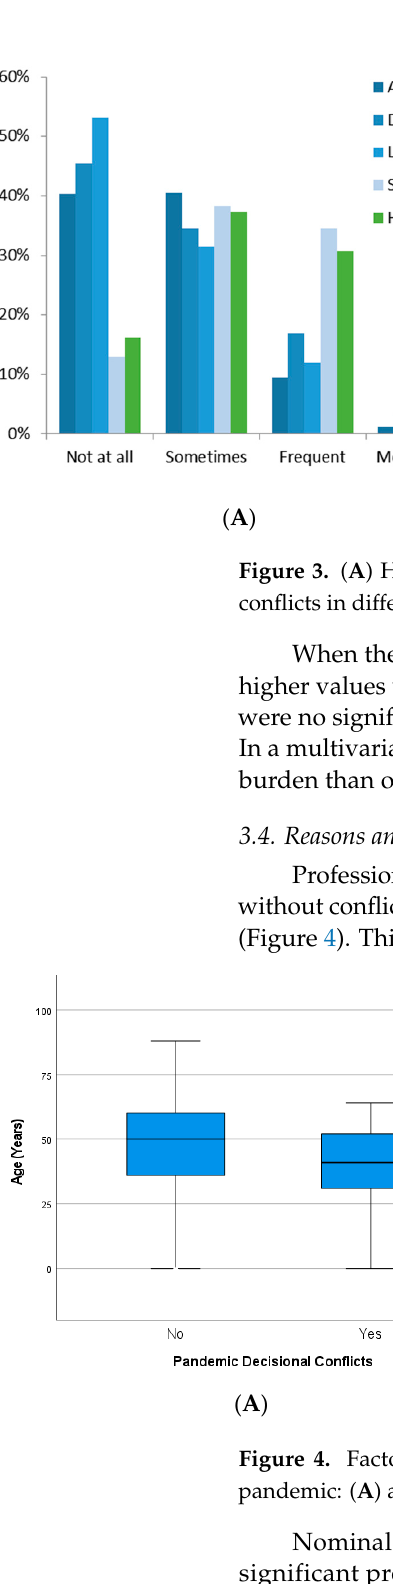
Quotient Test for regression parameters and (B) resulting classification.